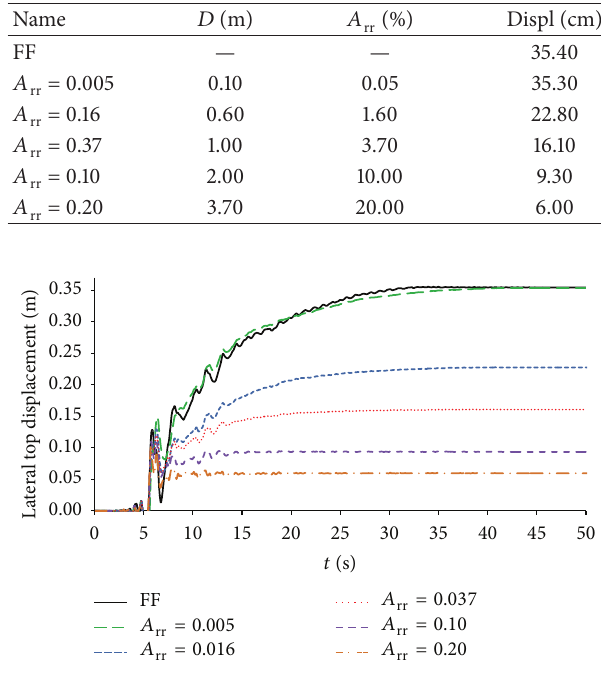
Figure 8: Lateral displacement at surface (0.00 m) time